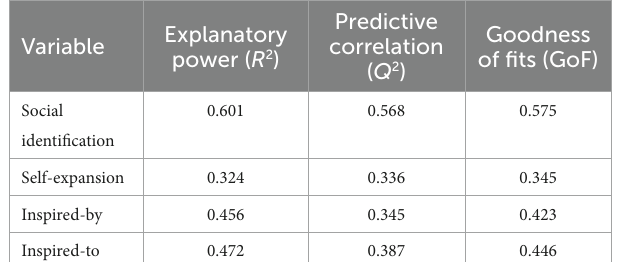
TABLE 4 Structural model